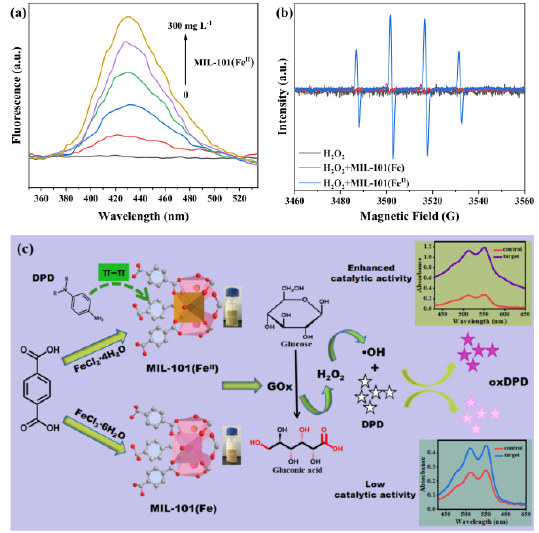
Figure 10. ( a ) Fluorescent measurements, ( b ) EPR measurement of •OH, and ( c ) Colorimetric determination of H 2 O 2 and glucose based on MIL − 101(FeII) catalysis [67].